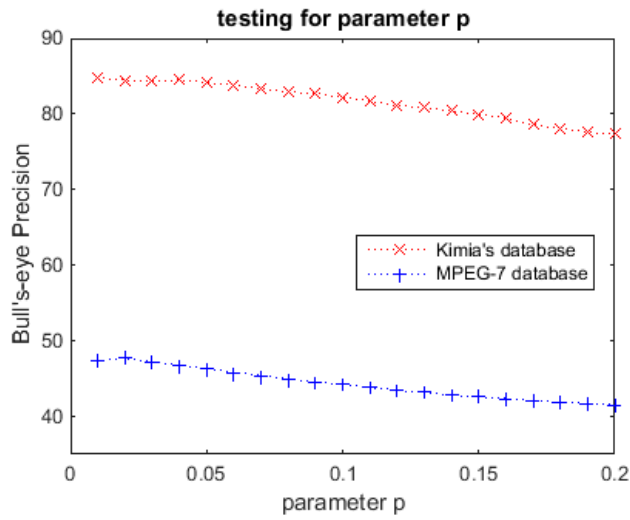
Figure 7. Bull’s-eye test with different values for parameter p in Equation (17).